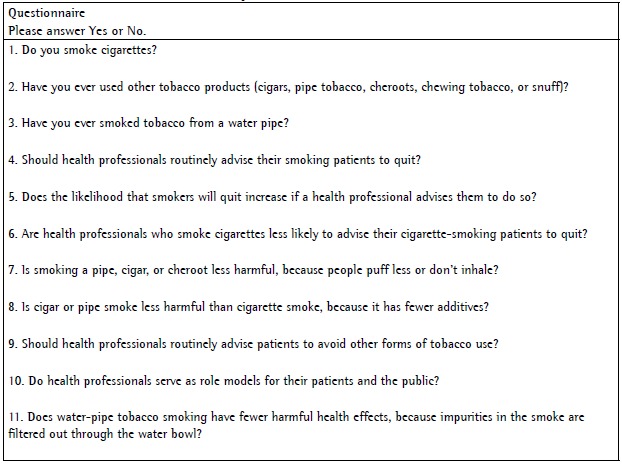
Questionnaire used in the study